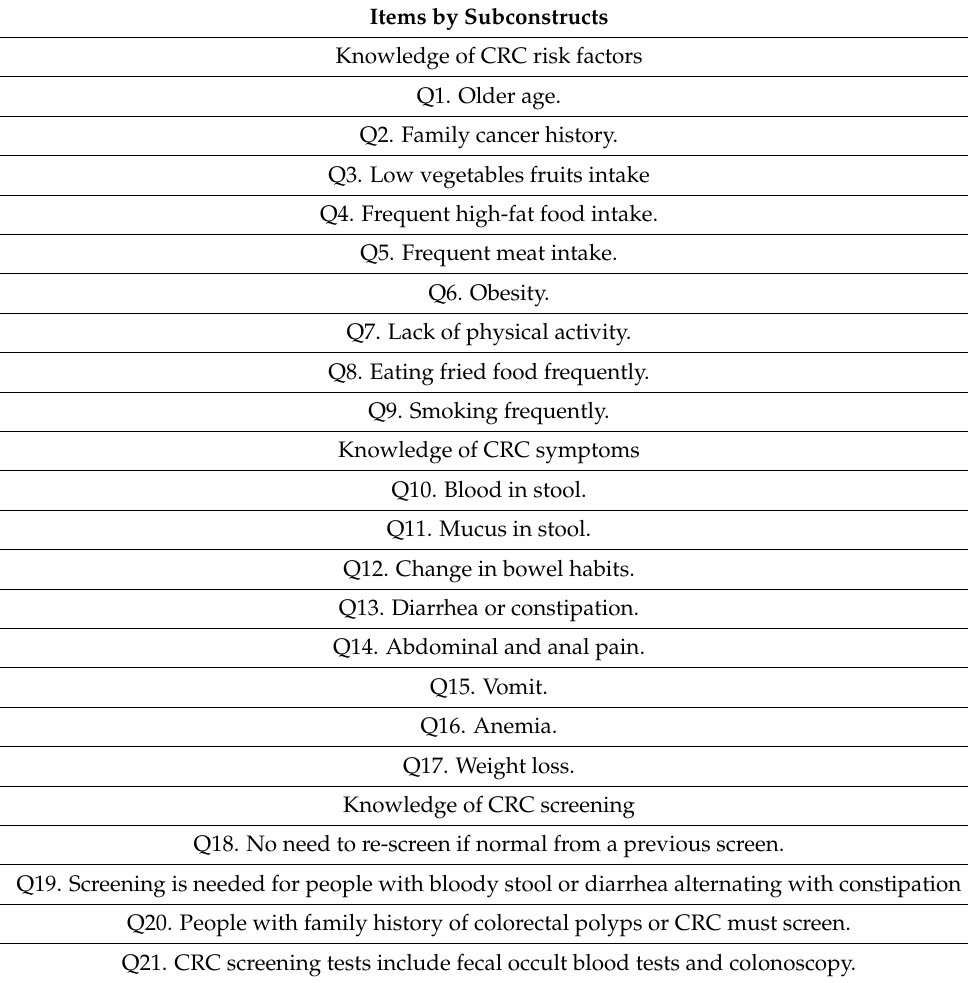
Table A1. Items of the 21-item for CRC knowledge questionnaire.